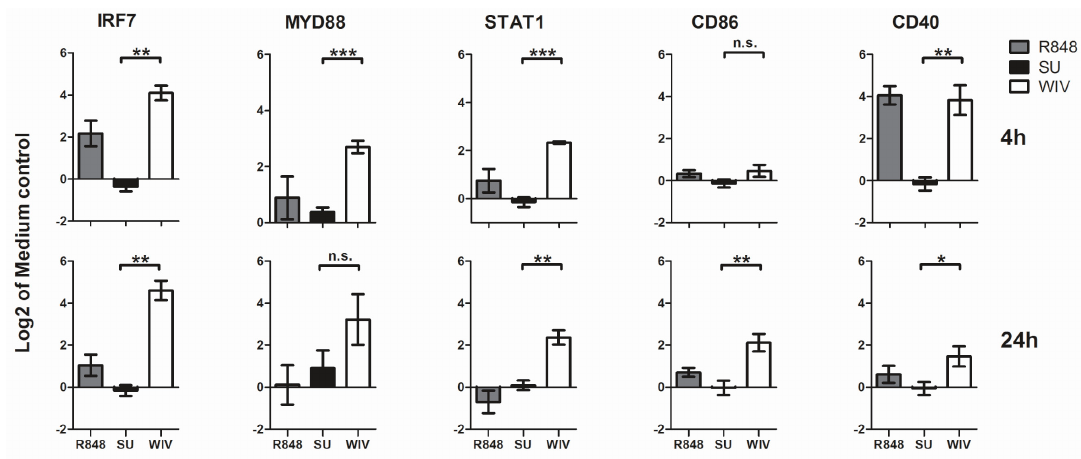
Figure 3. Gene expression shows that Mo-DCs respond to stimulation with R848 and two different influenza formulations in distinctive ways. Immature DCs were stimulated with WIV, SU and R848 for 4 h (upper panel) and 24 h (lower panel), RNA was isolated and gene expression was assessed by reverse transcription polymerase chain reaction (RT-qPCR). Bars represent the mean log2 fold change in gene expression as compared to the medium control of four different donors +/ − standard deviation. Levels of significance: n.s.: p > 0.05; *: p ≤ 0.05; **: p ≤ 0.01 and ***: p ≤ 0.001.